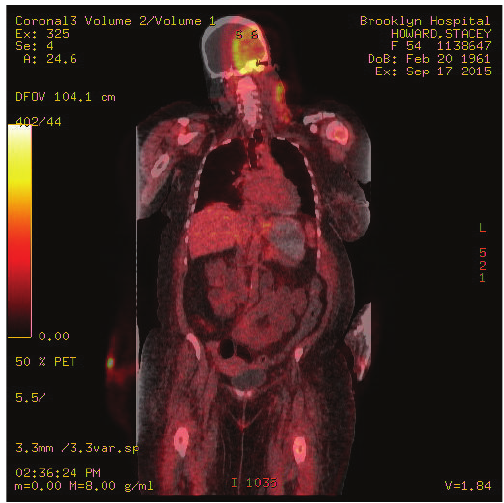
Figure 3: Positron Emission Tomography/Computed Tomography (PET/CT) showing minimal FDG uptake at the large mass lesion at the left ethmoid and maxillary sinuses, moderate to significant FDG uptake at bilateral cervical lymph nodes, and minimal heterogeneous FDG uptake along the thoracolumbar vertebra and pelvic bones.